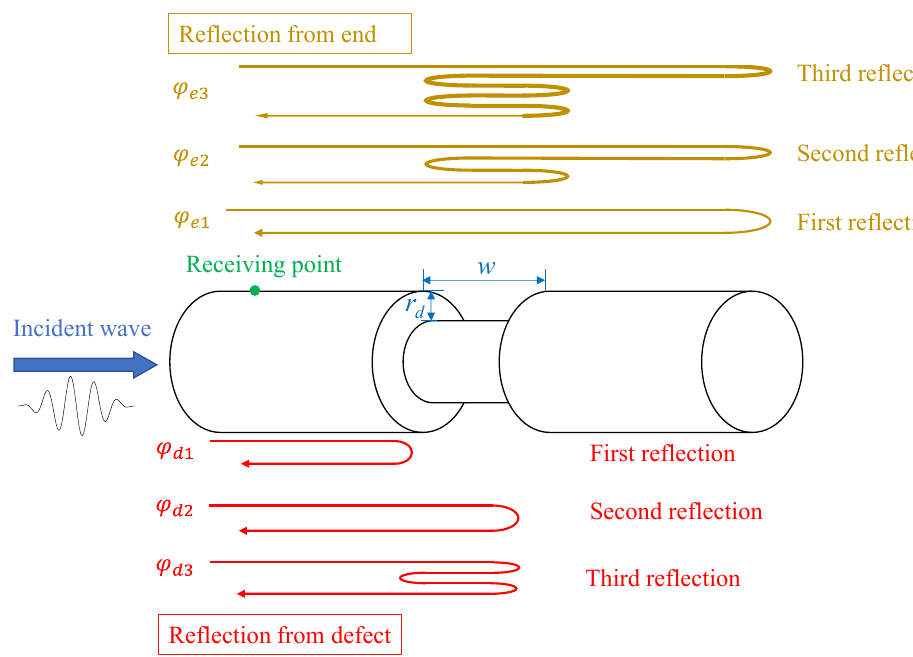
Figure 3. Sketch of the torsional wave reflections in a damaged cylindrical structure. The reflected torsional wave from the defect at the receiving point is the result of the superposition of the waves associated with different reflection paths as sketched in Figure